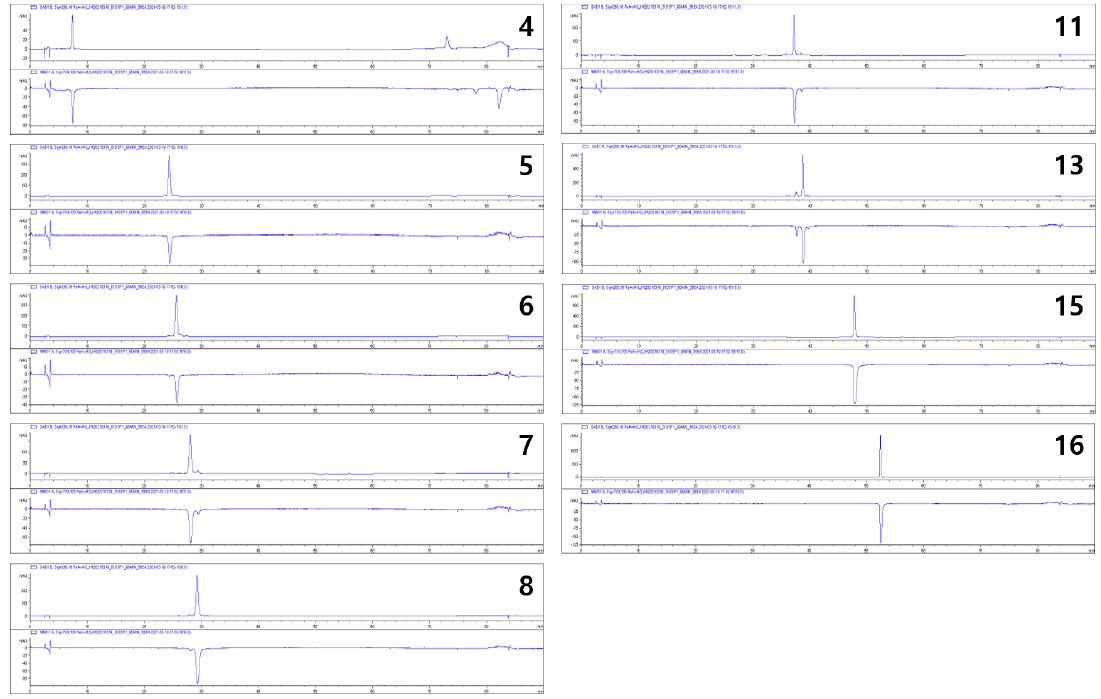
Figure 4. Radical scavenging activities of the isolated compounds ( 4 – 8 , 11 , 13 , 15 , and 16 ) assessed by online HPLC-ABTS assay.